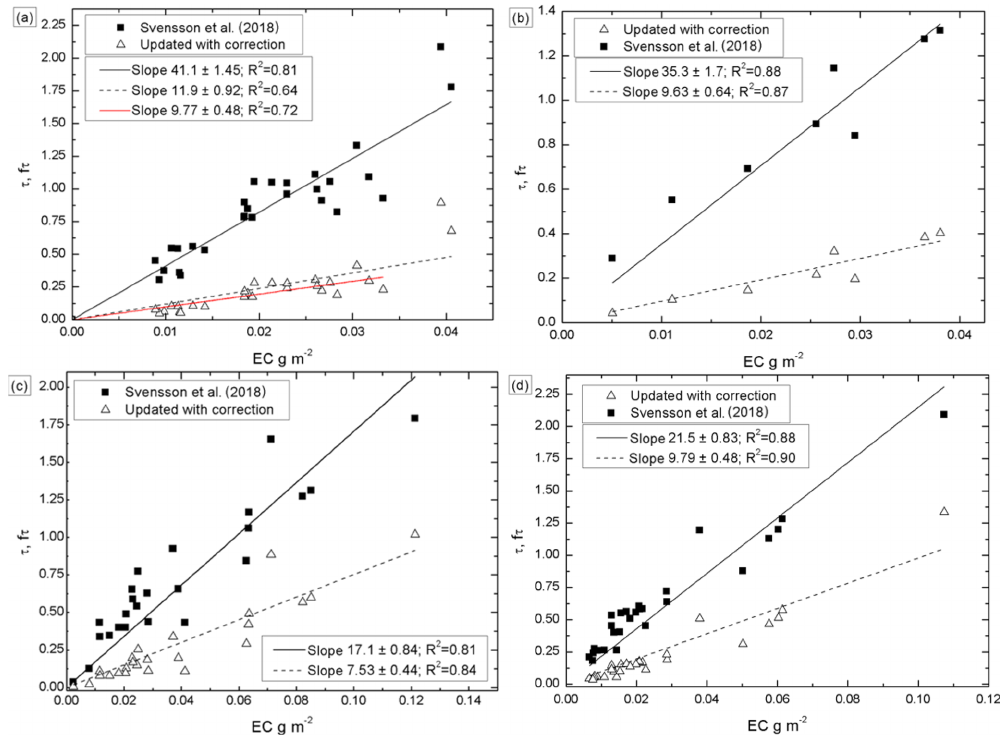
Figure 9. Reanalysis of linear regressions presented by Svensson et al. (2018). (a) chimney soot, with the red line showing the slope with the two points with the highest EC content excluded, (b) NIST soot, (c) field samples from the Indian Himalaya, and (d) field samples from Finnish Lapland. On the x axis is the EC concentration (in gm − 2 ), and on the y axis are the non-corrected and corrected optical depth, τ and f τ ,